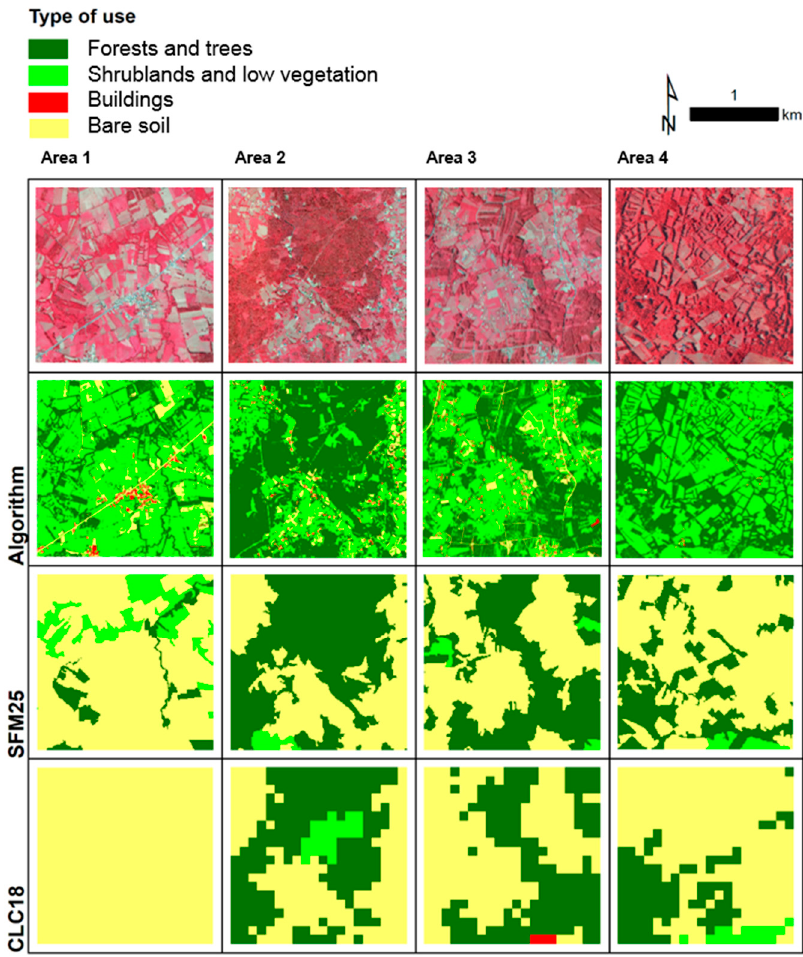
Figure 3. False colour RGB representation from aerial imagery and land use classification (algorithm developed for this study, SFM25, and CLC18) for the four study areas.